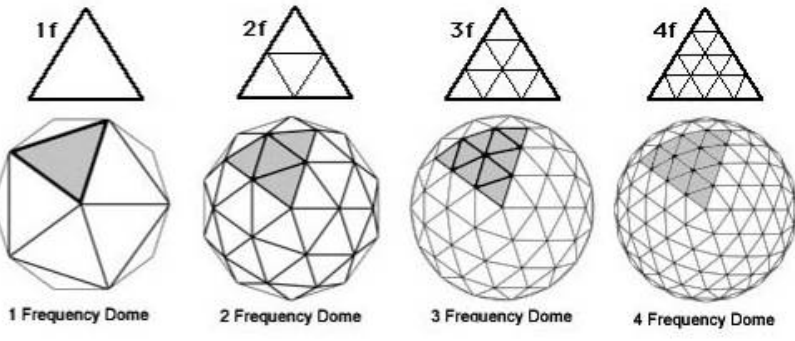
Figure 5: Different subdivisions of triangulated geodesic all-glass